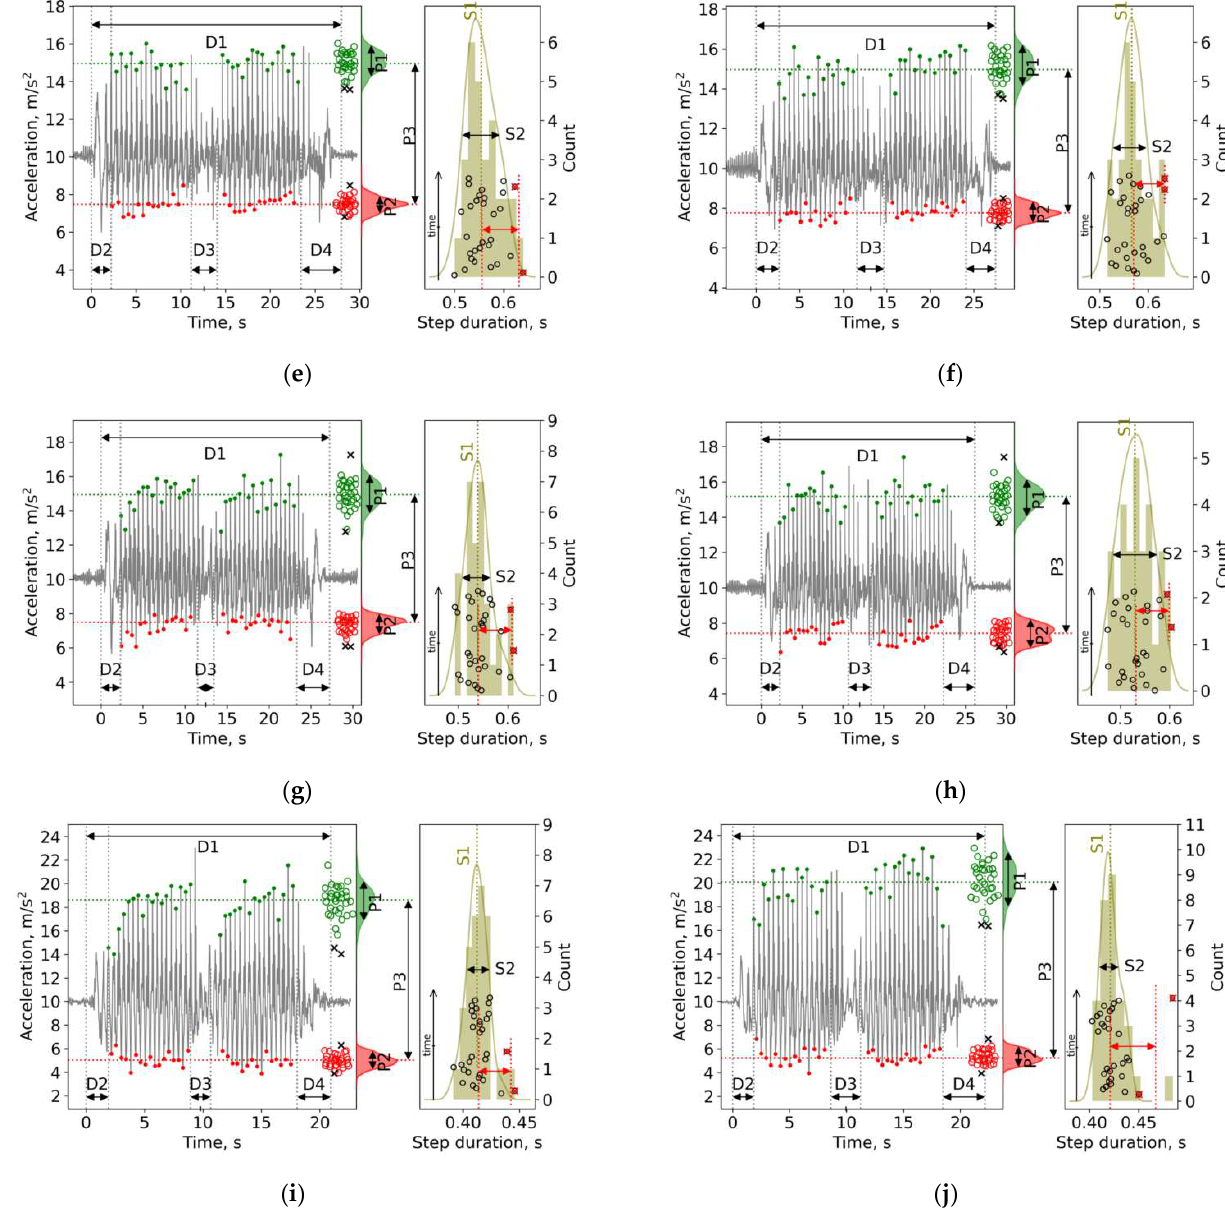
Figure 3. Individual plots for five separate DI sessions in three subjects. For details, see Figure 2: ( a ) Subject 1 before and ( b ) after the 1st DI; ( c ) Subject 1 before and ( d ) after the 7th DI; ( e ) Subject 2 before and ( f ) after the 5th DI; ( g ) Subject 2 before and ( h ) after the 4th DI; ( i ) Subject 3 before and ( j ) after the 7th DI.